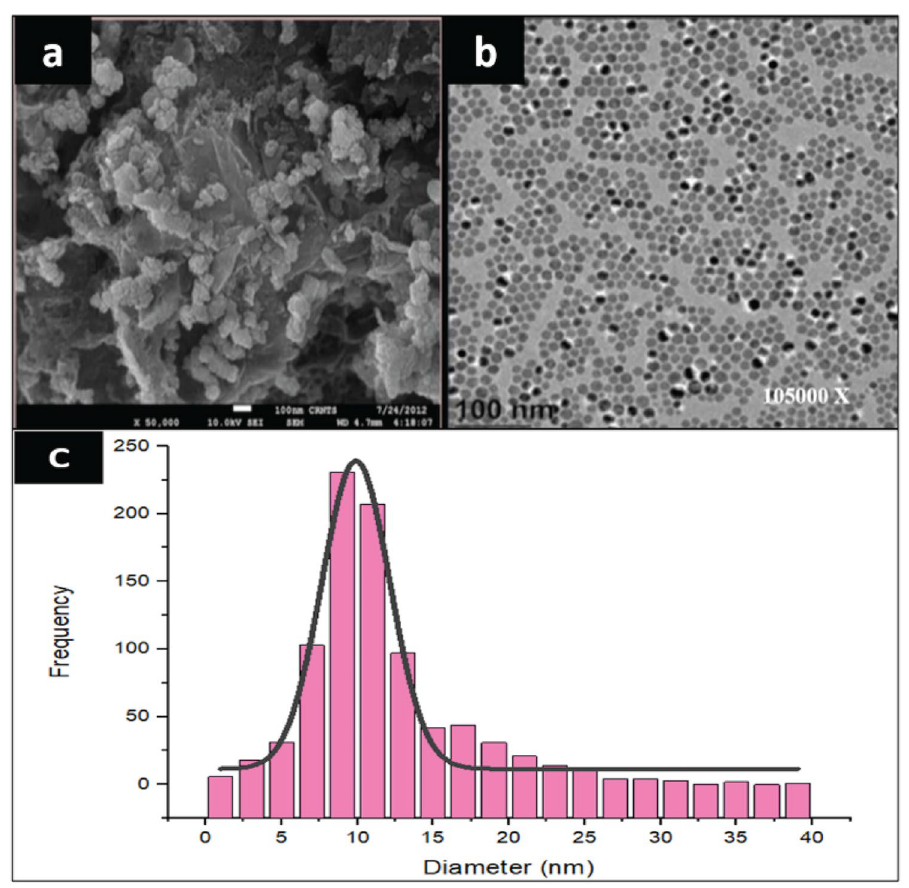
Figure 7. The SEM and TEM analysis of GINPs and size distribution of GINPs. ( a ) Depicts the SEM and ( b ) highlights the TEM analysis of GINPs. ( c ) The Histogram indicates that the size of GINPs was between the range of 5–40 nm. However, the highest frequencies were between 7.5 and 12.5 nm.